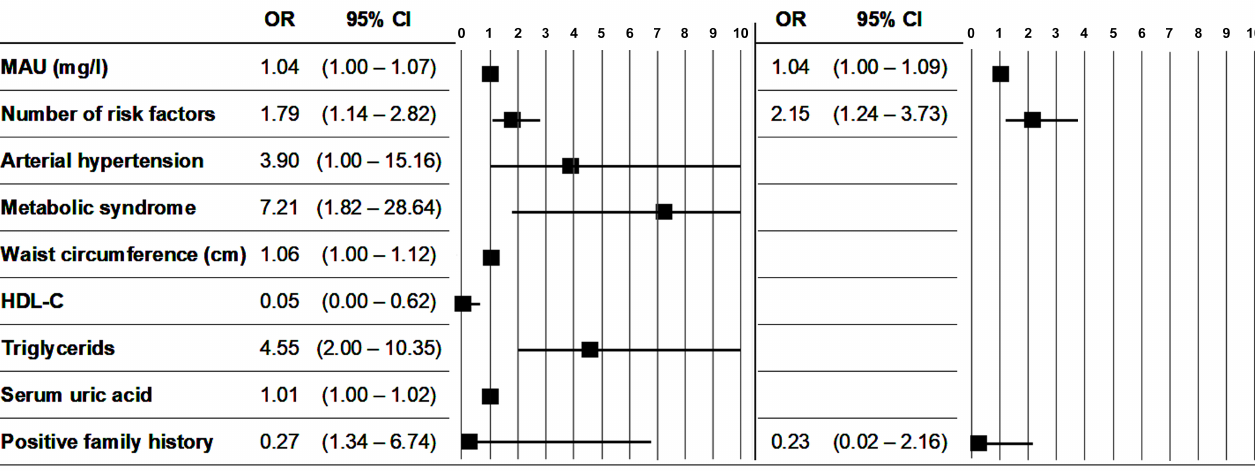
Figure 2. The results of univariate and multivariate logistic regression of the carotid artery plaque occurrence. After adjusting for potential confounders, microalbuminuria and the number of risk factors were identified as independent predictors for the occurrence of carotid plaque. Odds ratio and 95% confidence interval. Note: OR: odds ratio; N: number; left side: univariate logistic regression; right side: multivariate logistic regression; MAU: